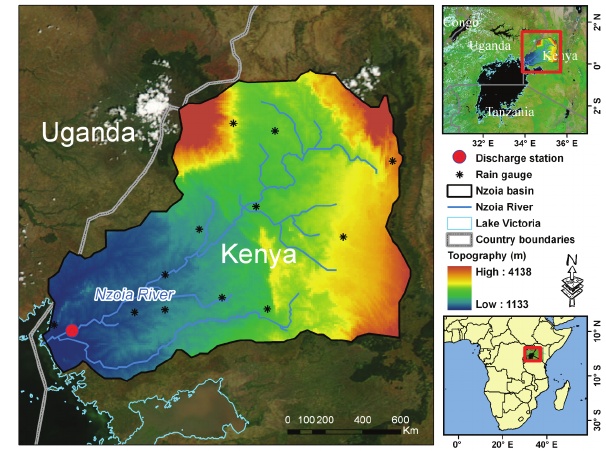
Fig. 1. Map of Nzoia river basin in Lake Victoria region, East Africa.